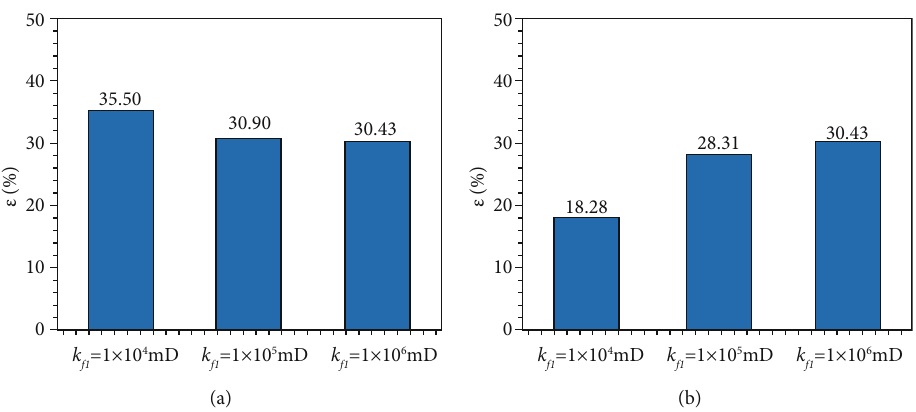
Figure 11: Increase ratio of the cumulative production with (a) di ff erent initial fracture permeability. (b) Di ff erent refracture